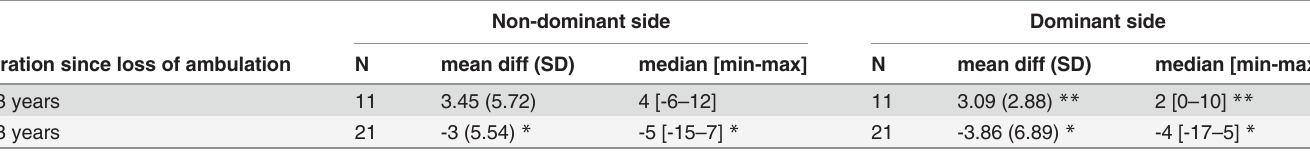
Duration since loss of ambulation